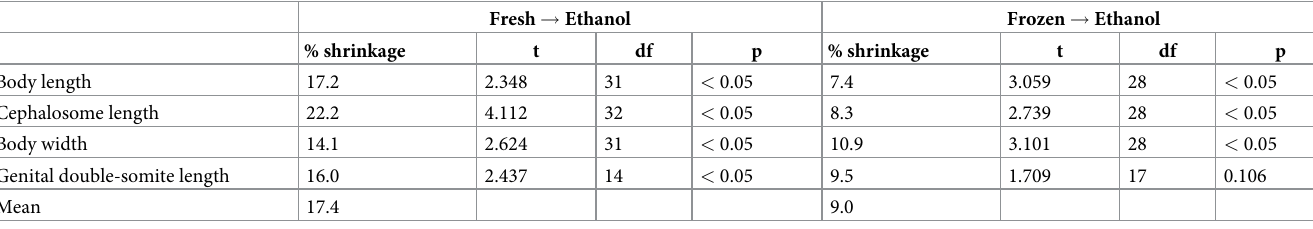
Table 2. Effects of preservation and storage methods on morphology of Mytilicola spp.